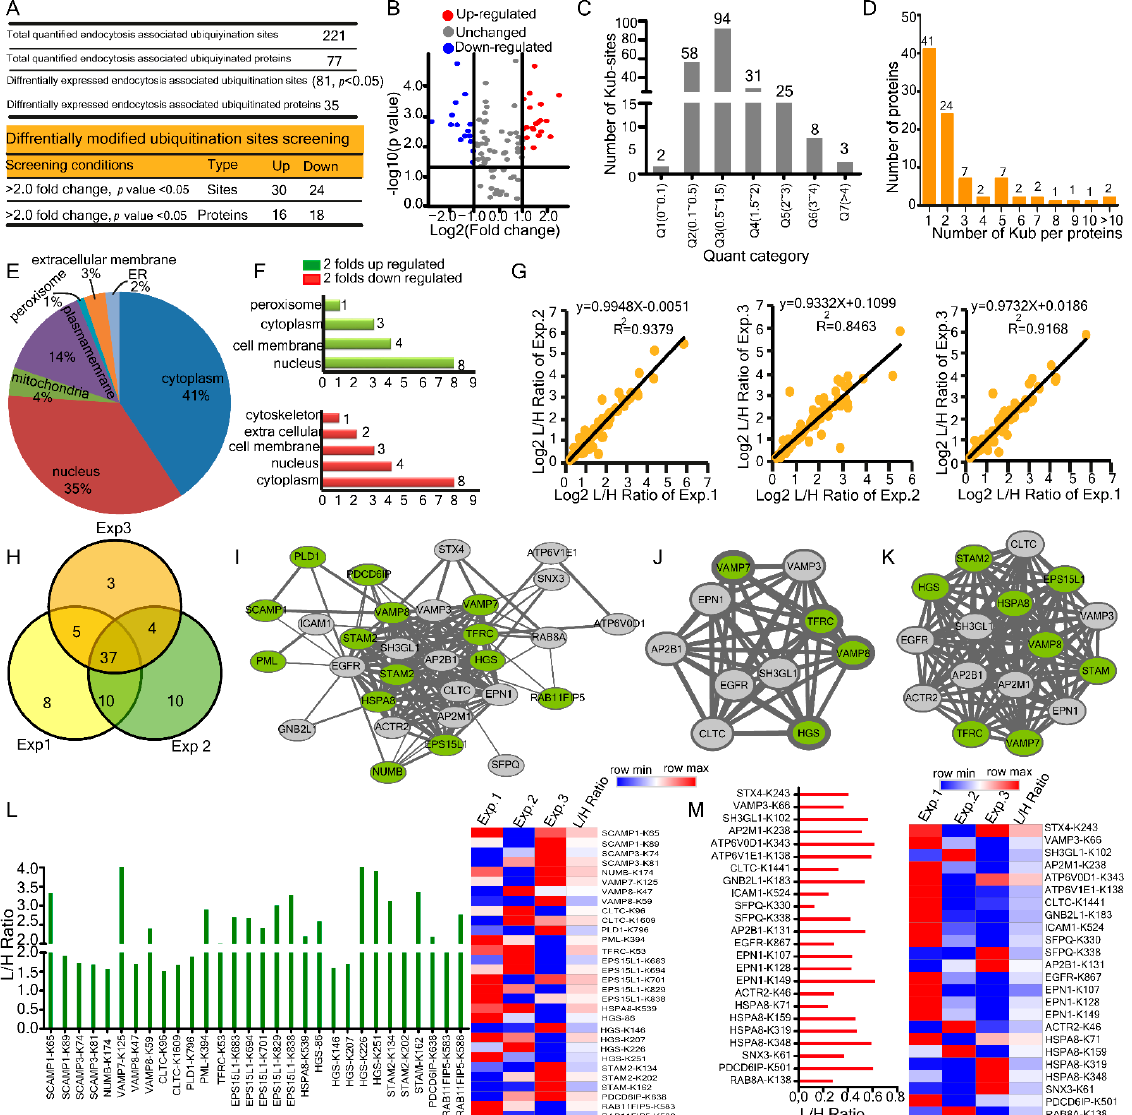
Figure 3. Host endocytosis associated ubiquitylome modifications upon HBV infection. ( A ) Summary of quantified and differentially expressed proteins and Kub-sites. ( B ) The identified endocytosis associated Kub-sites are shown in a volcano plot. ( C ) Distribution of regulated Kub-sites quantification results. ( D ) Association between the number of proteins and the number of Kub-sites per protein is shown. ( E,F ) The subcellular localization of differentially expressed and two folds up &down-regulated proteins. ( G ) Pearson’s correlation (R 2 ) plots for three representative experiments from HepG2.2.15 cells. ( H ) Venn diagrams for three representative experiments of Kub-sites in HepG2.2.15 cells, Kub-sites numbers are indicated ( I ) Protein-protein interaction network constructed with the up and down-regulated ubiquitinated DEPs, green nodes represent up-regulated ubiquitinated proteins, and grey nodes represent down-regulated. DEPs = differently expressed proteins. ( J ) The defined hub genes identified by CytoHubba plugin by degree method through ubiquitinated DEPs PPI network. ( K ) The most significant module selected by the MCODE plugin, comprising 16 nodes and 120 edges. ( L ) L/H ratios for two folds up-regulated Kub-sites from three biological replicates in HepG2.2.15 cells along with heatmap representation. ( M ) L/H ratios for two